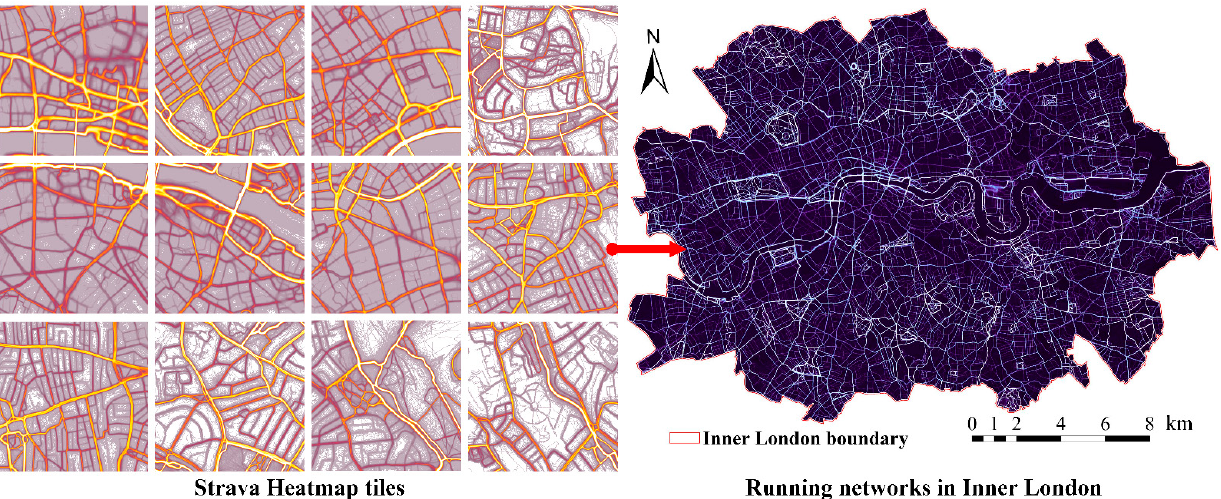
Figure 3. Tiles of 512 × 512 pixels captured from SH and the complete running heat map of Inner London made up of 594 tiles.